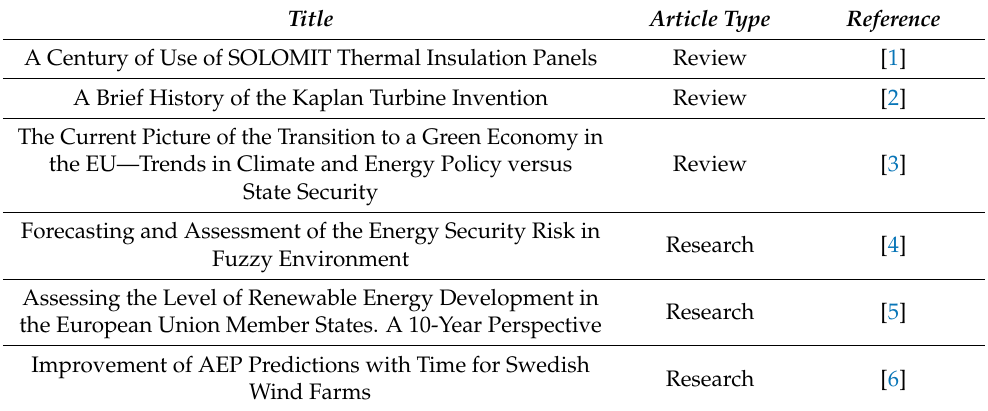
Table 1. The articles published in the 2021 Energies Special Issue “Energy—History and Time